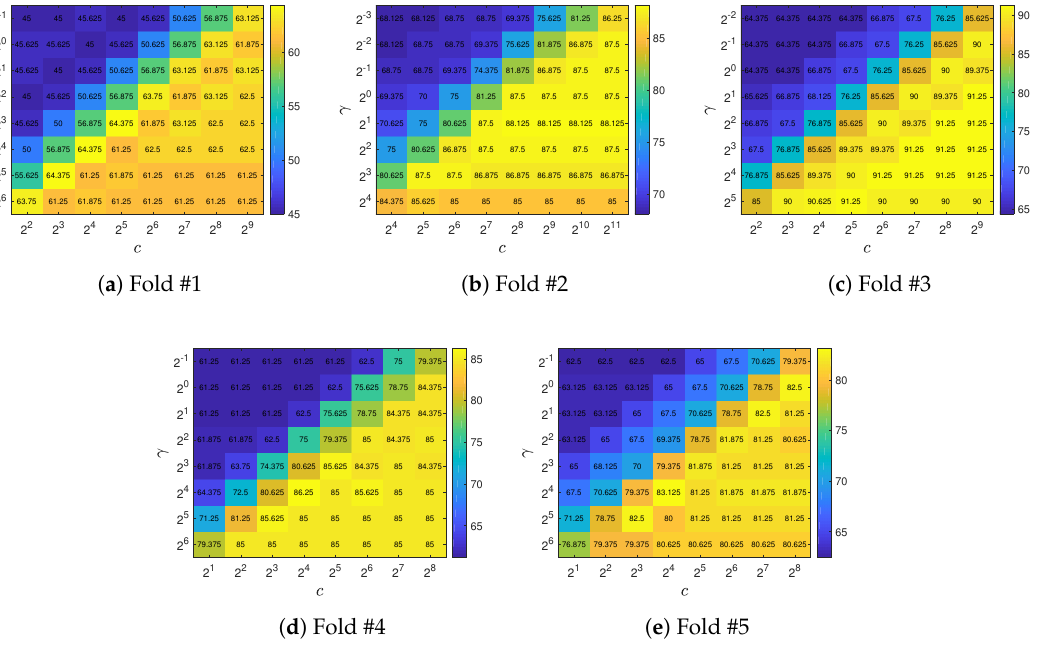
Figure 12. Grid search results (%) for C-SVM over 5-fold